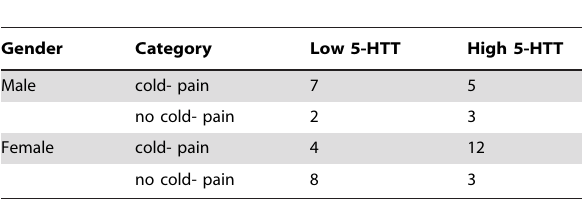
Table 3. Contingency table for cold-pain thresholds.